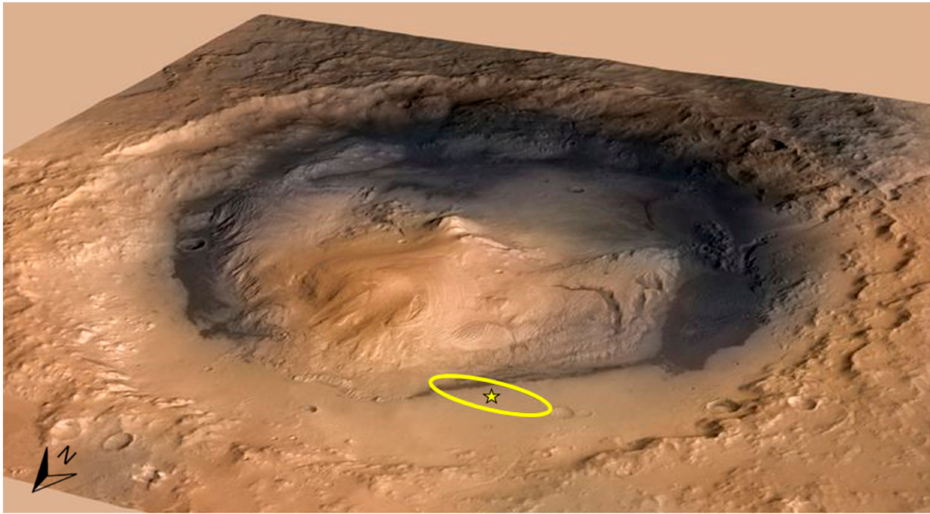
Figure 1. Gale crater is 155-km in diameter and contains a 5-km high mound of stratified rock. Strata in the lower section of the mound vary in mineralogy and texture, suggesting that they may have recorded environmental changes over time. The yellow oval denotes the MSL landing ellipse and the star denotes the landing site. Image credit: NASA/JPL-Caltech/ESA/DLR/FU Berlin/MSSS. (accessed on 23 July